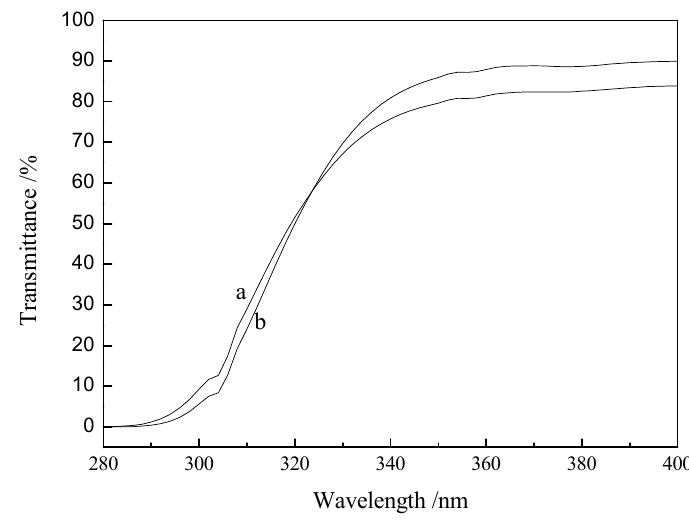
Figure 3. The transparency of citral ( a ) and VS-citral ( b ) measured in the range of the UV-A and UV-B region (280–400 nm).